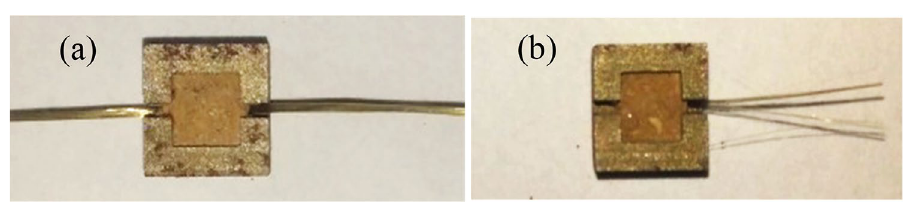
Figure 9. The sample photos. ( a ) Basalt fiber before the test. ( b ) Basalt fiber surface attachment after the